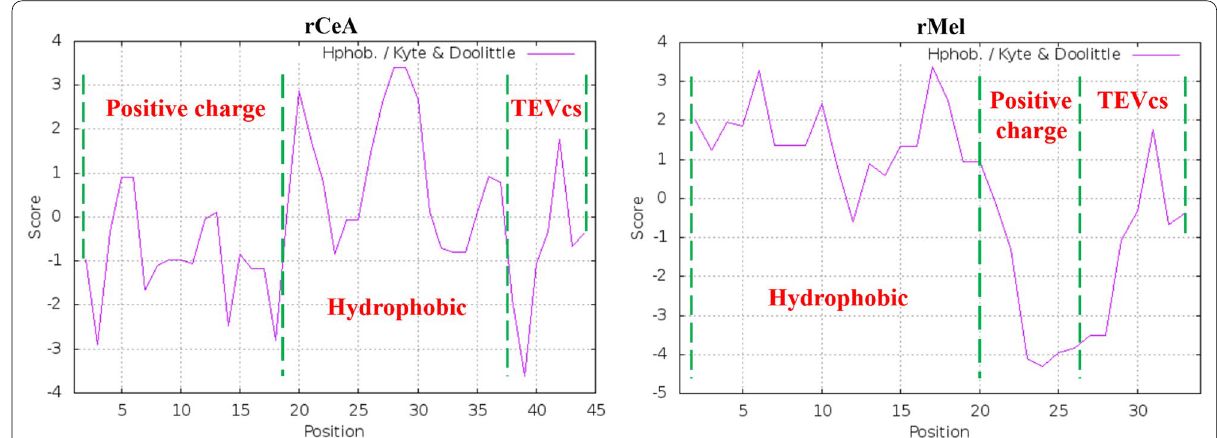
Fig. 8 Charge and hydrophobicity profiles of recombinant rCeA and rMel analyzed by ExPASy. The amino acid sequences of rCeA and rMel were import into https:// web. expasy. org/ prots cale/ and analyzed by Hphob/Kyte & Doolittle mode